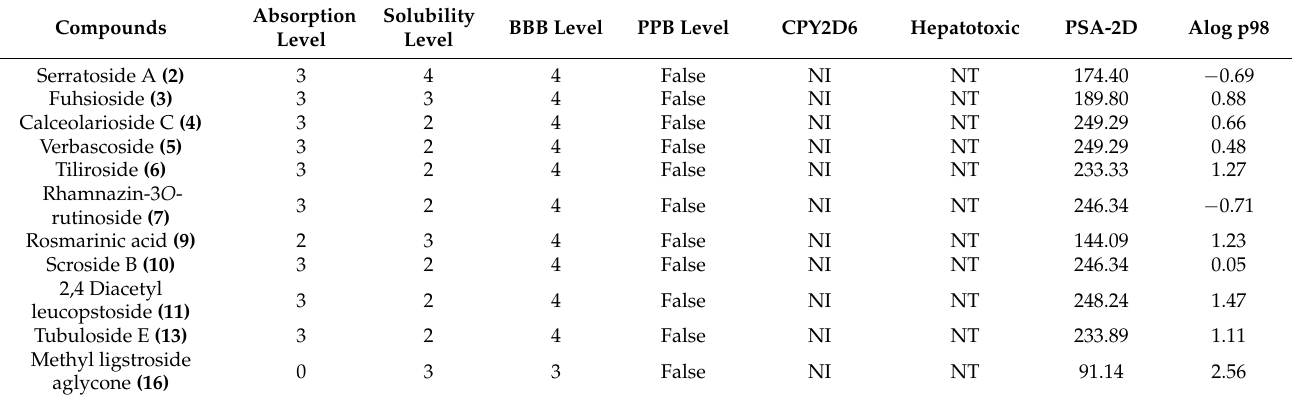
Table 4. ADMET (Absorption, distribution, metabolism, excretion, and toxicity) properties of the major compounds identified in the total methanol extract of C. speciosum leaves.